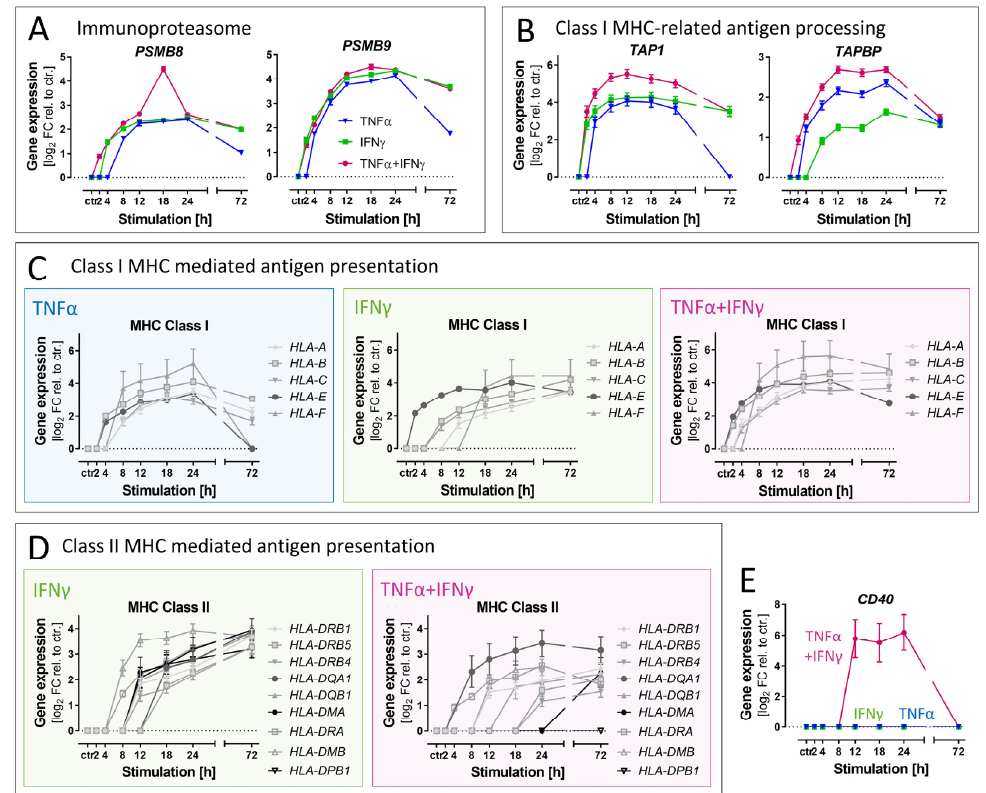
Figure 6. Differential effects of cytokines on the antigen presentation program in astrocytes. Gene expression data were obtained from ACs as detailed in Figure 4. Genes involved in antigen processing and presentation were selected for detailed analysis. ( A ) Levels of mRNA for immunoproteasome subunits. ( B ) Levels of mRNA for proteins involved in the transport of peptides to be presented on MHC class I. ( C ) Levels of mRNA for MHC class I proteins. ( D ) Levels of mRNA for MHC class II proteins. Note that TNF α effects are not displayed as this cytokine did not affect the expression of MHC class II genes. ( E ) Exemplification of cytokine synergy by CD40, a pivotal enhancer on antigen ‐ presenting cells.